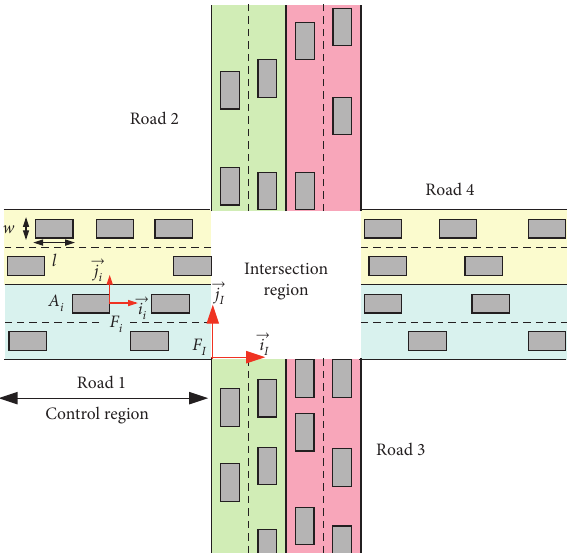
Figure 1: Illustration with the key features relevant to the formulation of the intersection control problem: the intersection and control regions, the geometry and dimensions of the vehicles, and the vehicle- and intersection-fixed